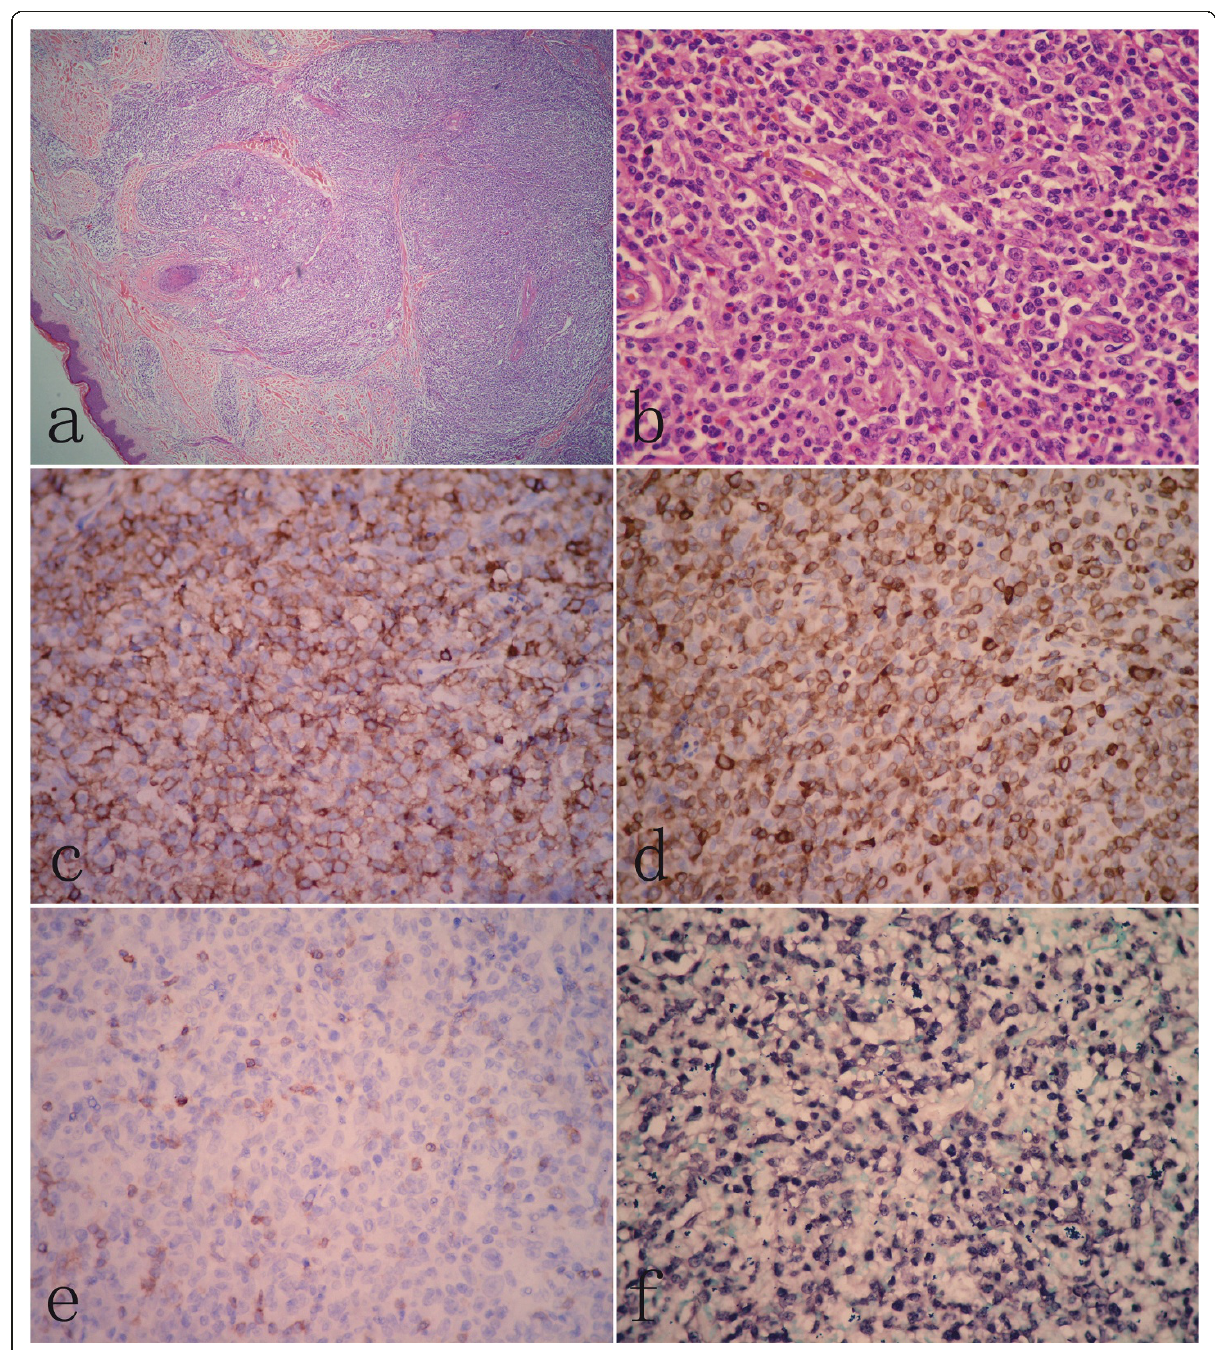
Figure 2 Histological findings of skin lesion . (A) Low power view of skin lesion showed diffuse infiltration of lymphoid cells in dermal and subcutaneous tissue without epidermotropism. (B) Large atypical lymphoid cells with prominent nucleoli were observed in the skin lesion. Atypical large lymphoid cells were stained positively with CD20 (C) and CD79a (D). However, CD3 positive cells in skin lesion were small lymphocytes with scattered distribution (E). (F) Most of atypical large cells were positive for EBER by in situ hybridization. (A, H&E staining, with original magnification ×40; B, H&E staining, with original magnification ×400; C-E, immunohistochemical staining, with original magnification ×400; F, EBER-in situ hybridization, with original magnification